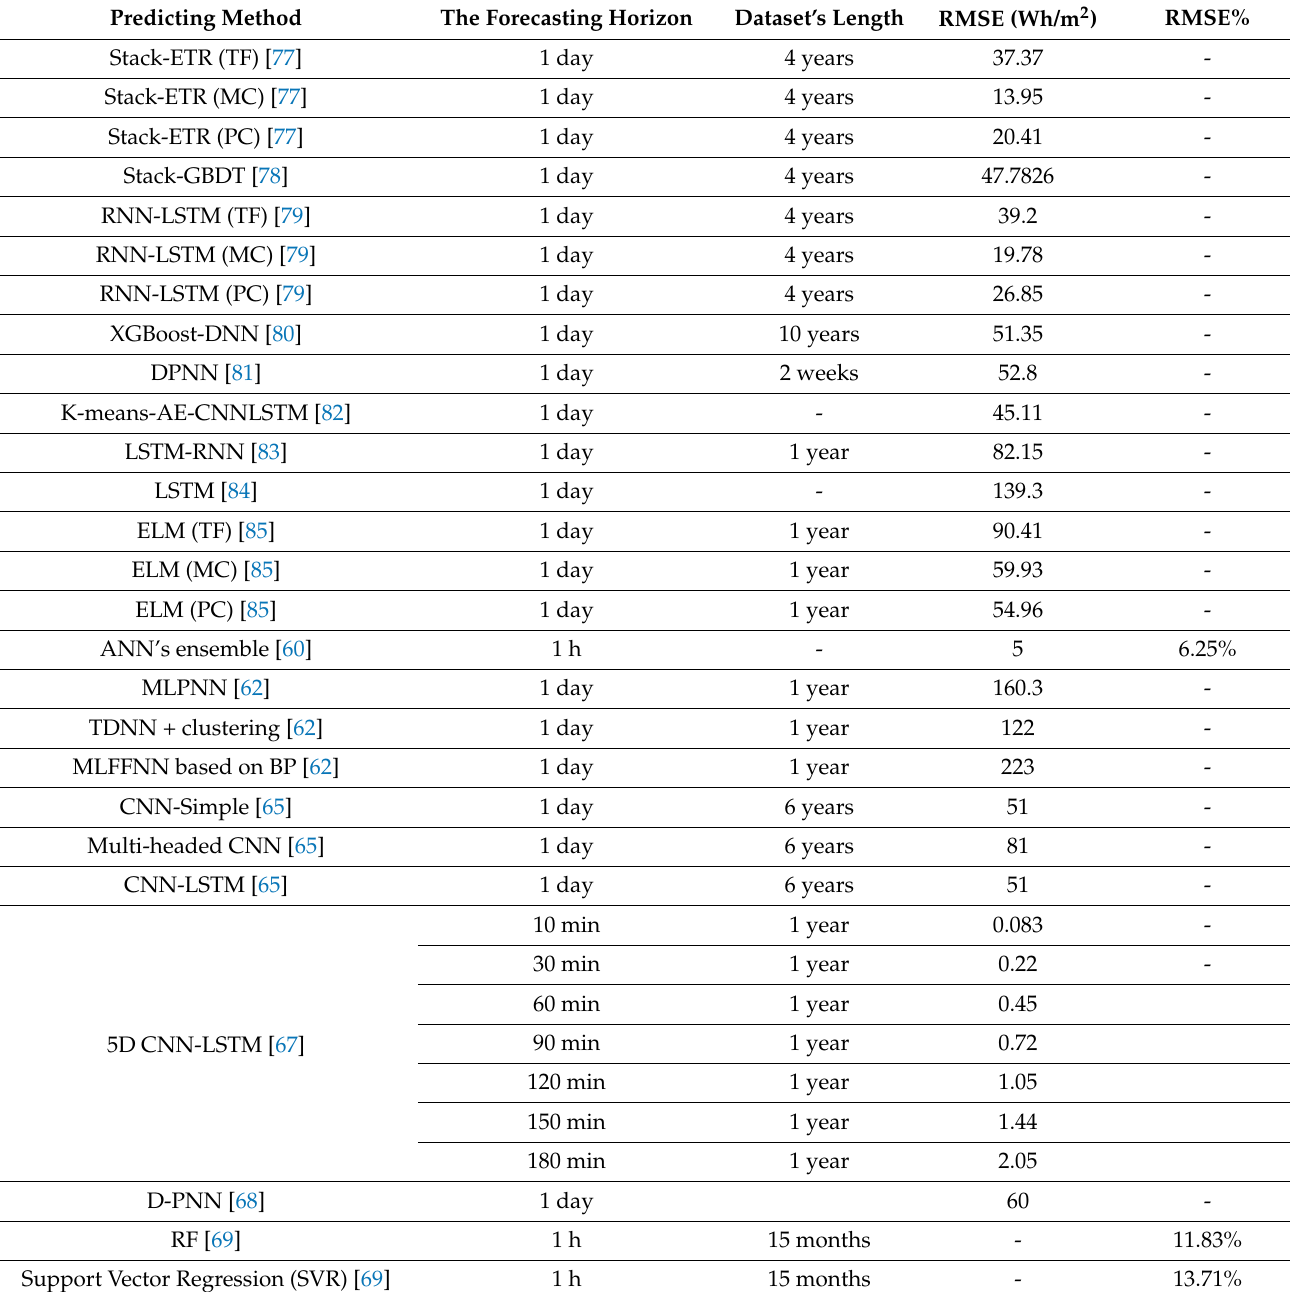
Table 7. The performances of the power forecasting ML